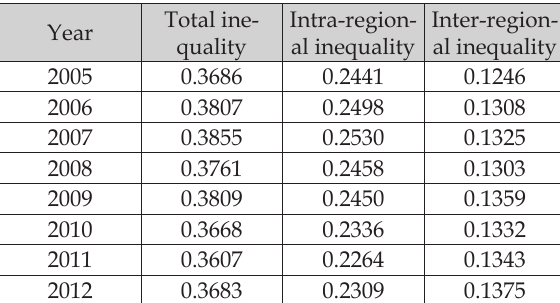
Table 2. Entropy measure of inequality on the basis of